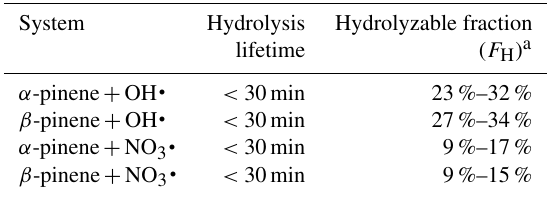
Table 2. Hydrolysis lifetime and corresponding fraction of hy- drolyzable p